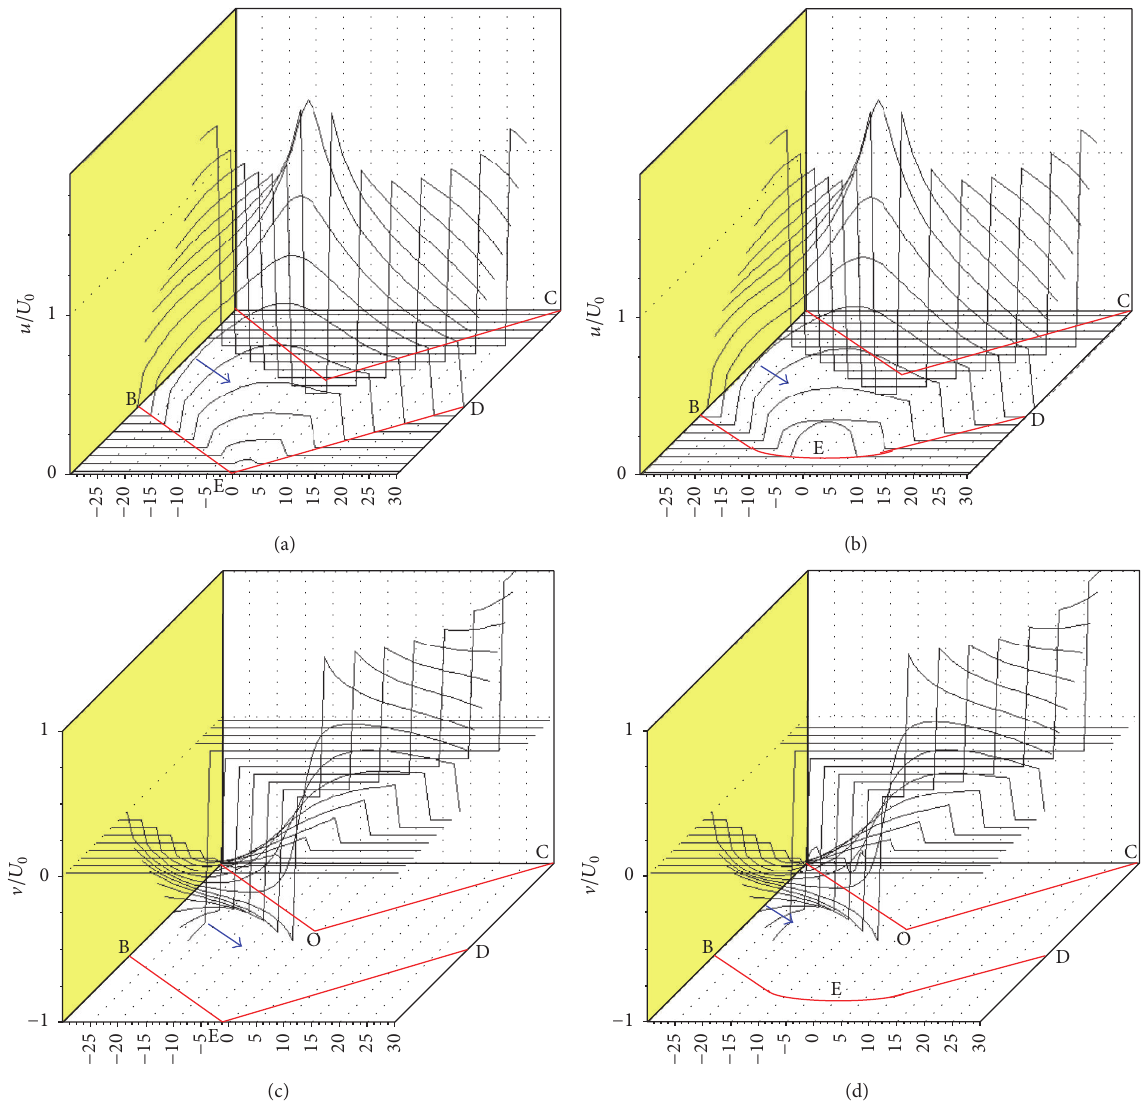
Figure 9: Computational diagrams for the dimensionless 𝑥 -projection 𝑢 of the flow velocity 𝑤 (a, b) and for the dimensionless 𝑦 -projection V of the flow velocity 𝑤 (c, d) for the viscous flow of the plasticine workpiece model through obtuse-angled equal channel angular dies AOC– BED of Segal (a, c) and Iwahashi geometries (b, d) with channel intersection angles ∠ (AOC) = 2 𝜃 = 105 ∘ and external rounding BED in channel intersection zones 𝑅 = 15mm (b, d), where the inlet AB is at the left and the outlet CD is at the